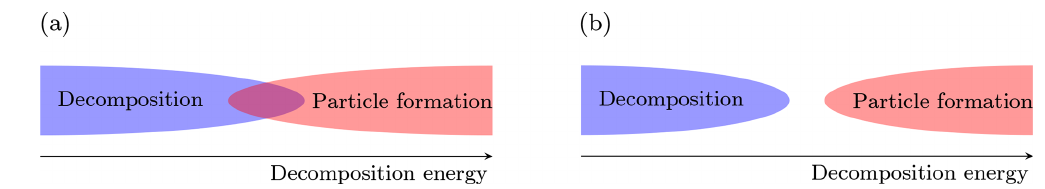
Figure 2. (a) The overlap between the decomposition and particle formation regions defines the range of decomposition energy at which both the events (decomposition in the APi-TOF MS and particle formation in the atmosphere) are allowed. (b) The two events are incompatible.